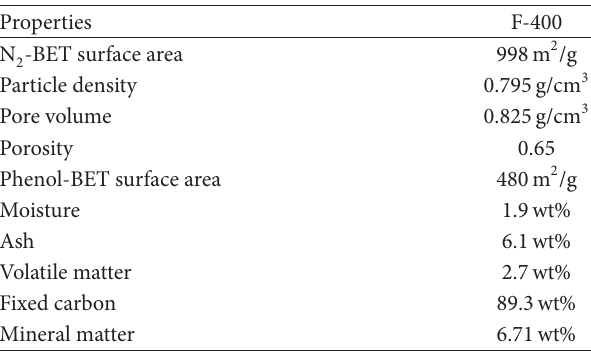
F 1: Langmuir adsorption isotherms at different temperatures. T 1: Physico chemical properties of adsorbent Filtrasorb-400.